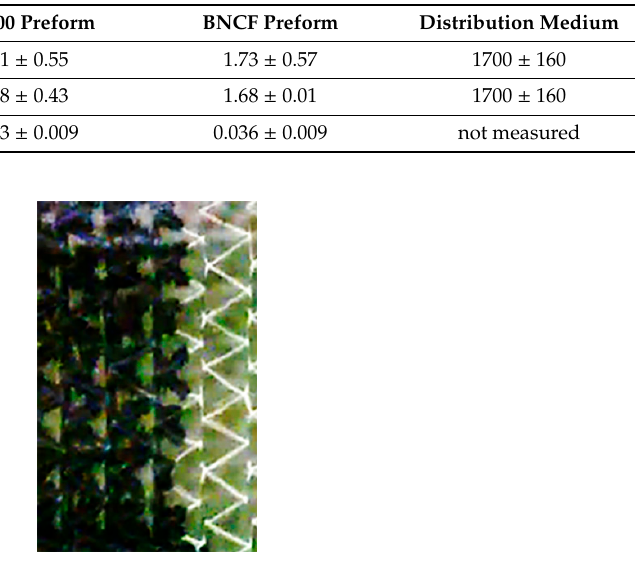
Figure 6. Flow front along stitches during infusion of BNCF preform.